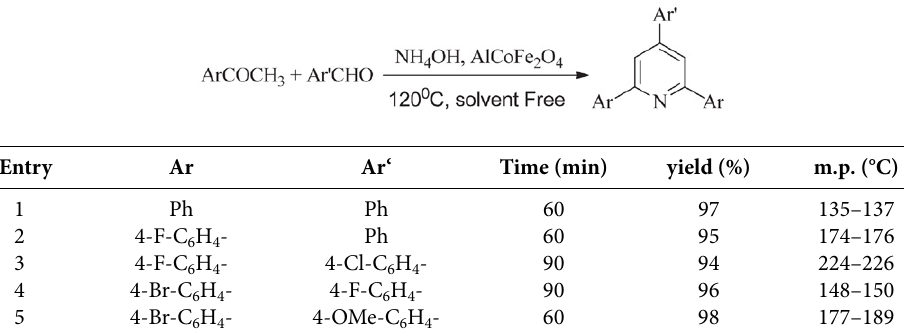
Table 3. Preparation of 2,4,6-triarylpyridine derivatives using AlCoFe 2 O 4